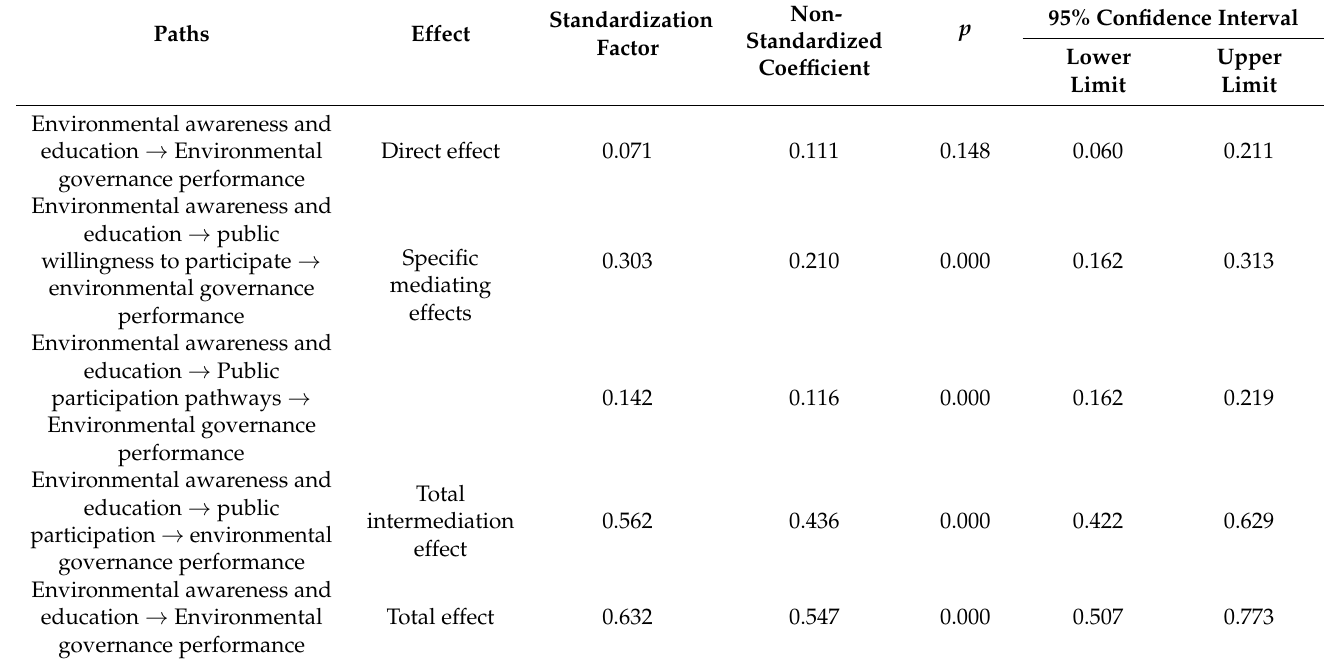
Table 7. Intermediary effect